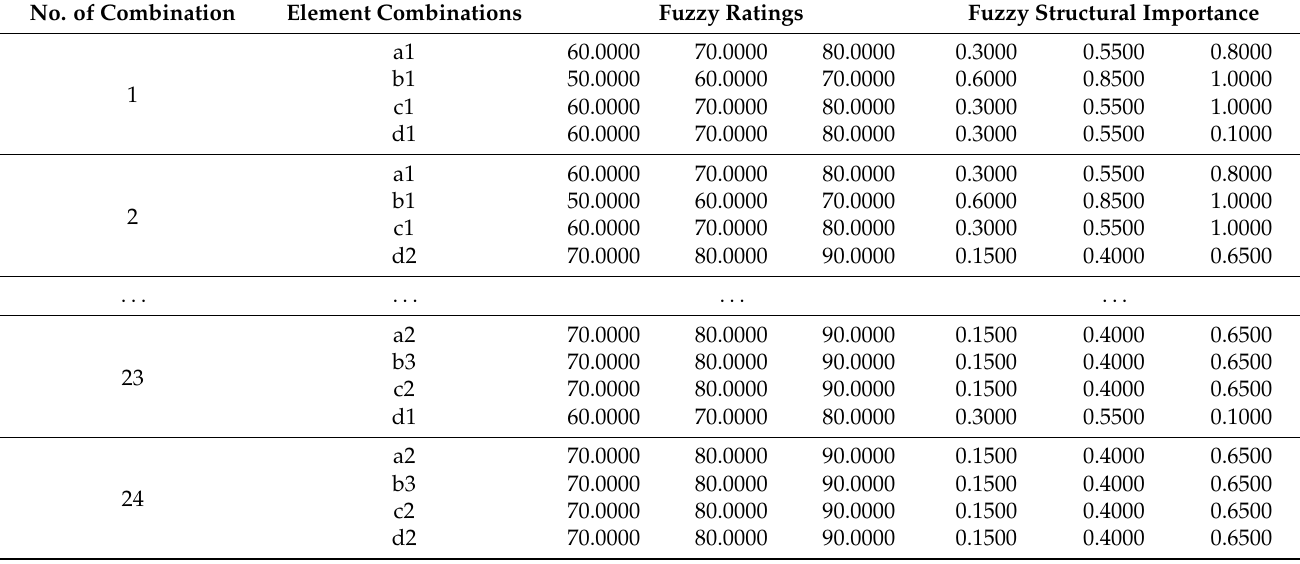
Table 5. Combinations of all elements with fuzzy ratings and fuzzy structural importance (shortened version-the first and the last two